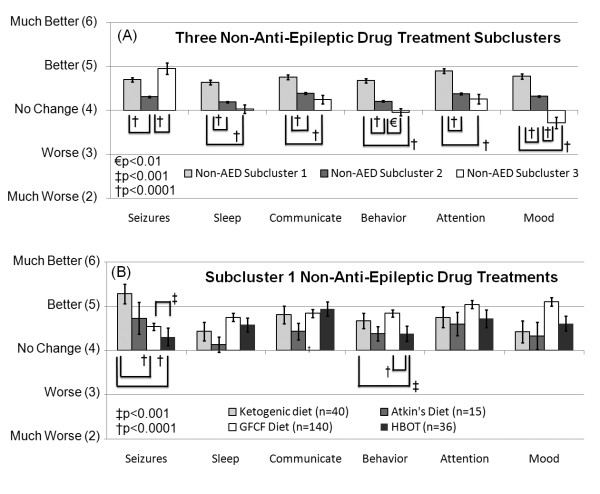
Rating for subclusters of non-anti-epileptic drug treatments for clinical seizures. (A) Non-anti-epileptic drug treatment subcluster 1 was perceived as improving seizures better than subcluster 2 and improving several other clinical factors more than subclusters 2 and 3. (B) The ketogenic diet was perceived to improve seizures more than the gluten-free-casein-free diet and hyperbaric oxygen treatment. Other clinical factors were not perceived to differ significantly between these four treatments except for behavior, which was perceived to be significantly worse with hyperbaric oxygen treatment as compared to the ketogenic diet and the gluten-free-casein-free diet.